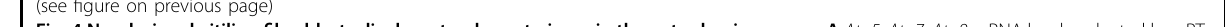
Fig. 4 Non-lesional vitiligo fi broblasts display a tendency to incur in the autophagic process. A Atg5, Atg7, Atg8 mRNA level evaluated by qRT- PCR in normal and non-lesional vitiligo fi broblasts (NHFs n = 5 and VHFs n = 5); B Immuno fl uorescence analysis of LC3 (red) and corresponding quantitative analysis of the number of LC3 positive puncta per cell. Nuclei were counterstained with DAPI. Quanti fi cation of positive puncta per cell is expressed as fold change relative to NHFs value, which was set as 1 by de fi nition ( n = at least 150 cells per group). Scale bar: 10 μ m; C Western blot